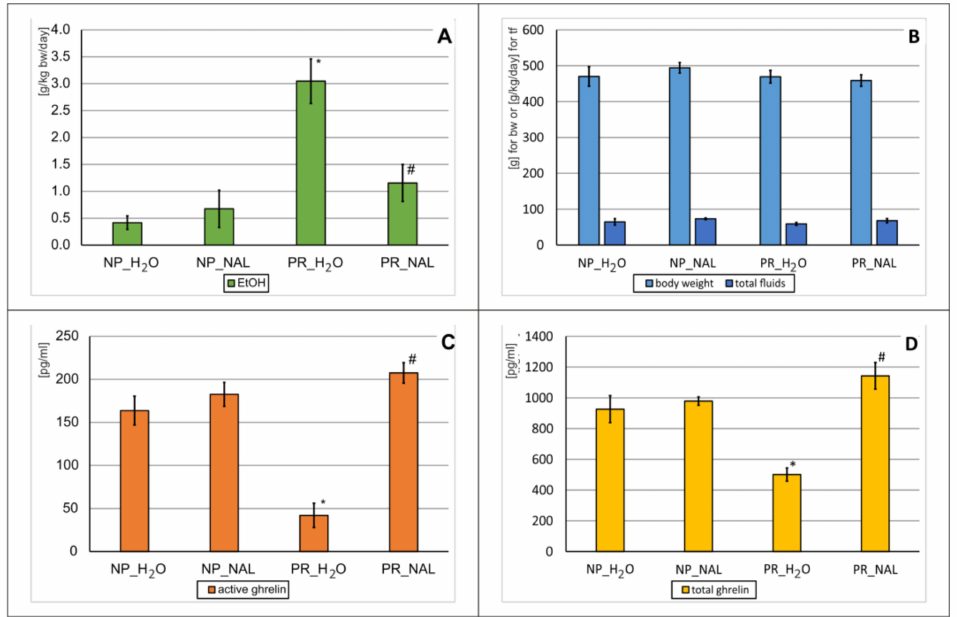
Figure 7. The effect of repeated (28 × ) naltrexone (NAL) (0.1 mg/kg, i.p.) administration on alcohol drinking behavior, total fluid intake, body weight, and ghrelin levels in preferring (PR) and non- preferring (NP) rats. Legend: n = 7; mean ± SEM; PR_H 2 O—control PR rats; NP_H 2 O—control NP rats; H 2 O—vehicle (water for injection); ( A ) amount of drunk ethanol [g/kg/day]; *—vs. NP_H 2 O group, p < 0.001; #—vs. PR_H 2 O group, p < 0.001; ( B ) body weight [g] and the total amount of fluid intake [g/kg/day]; ( C ) serum active ghrelin levels [pg/mL]; *—vs. NP_H 2 O group, p < 0.001; #—vs. PR_H 2 O, p < 0.001; ( D ) serum total ghrelin levels [pg/mL]; *—vs. NP_H 2 O group, p < 0.001; #—vs. PR_H 2 O, p <